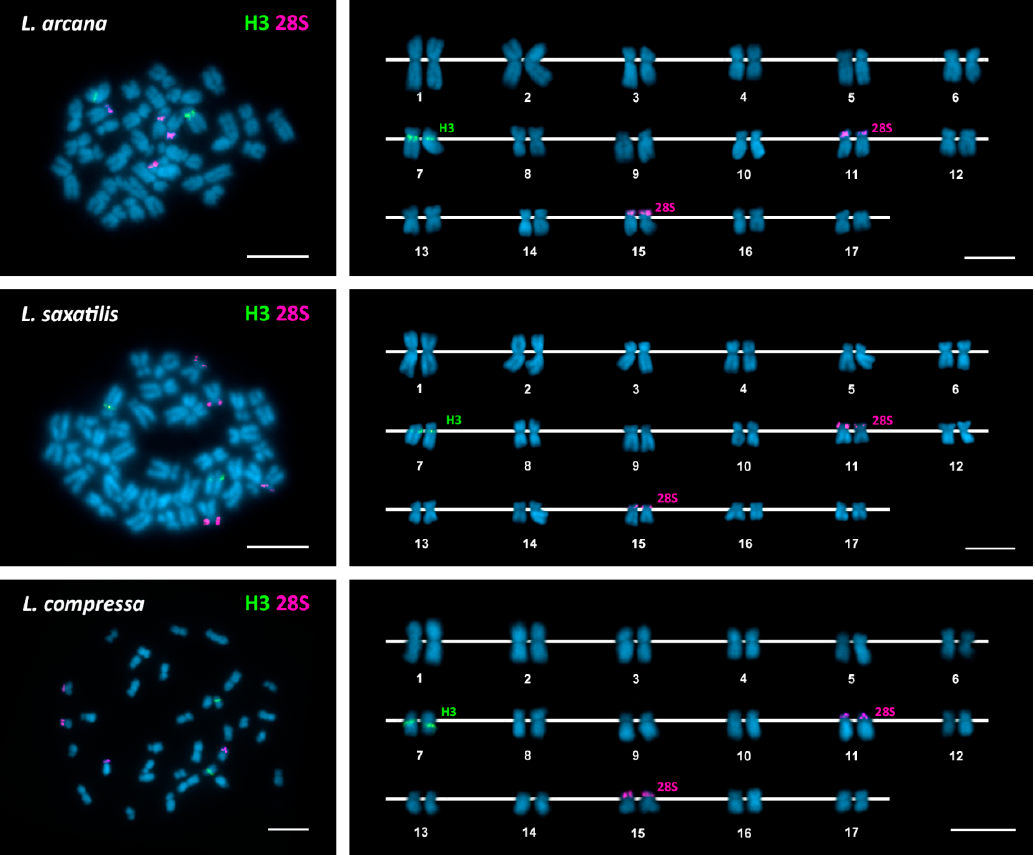
Figure 1. Chromosomal mapping of major rDNA and histone gene clusters in rough periwinkles. Fluorescent in situ hybridization mapping of H3 histone gene (H3, green) and major rDNA (28S, magenta) probes to mitotic chromosomes of the rough periwinkles Littorina arcana , Littorina saxatilis , and Littorina compressa counterstained with 4 ′ -6-diamidino-2-phenylindole (DAPI). Scale bars, 5 μ m.